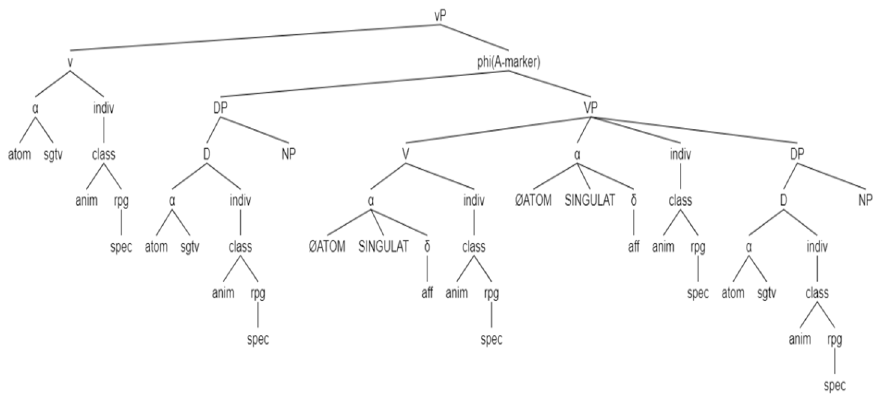
Figure 19. After insertion of v*, inheritance, Agree, and labeling.